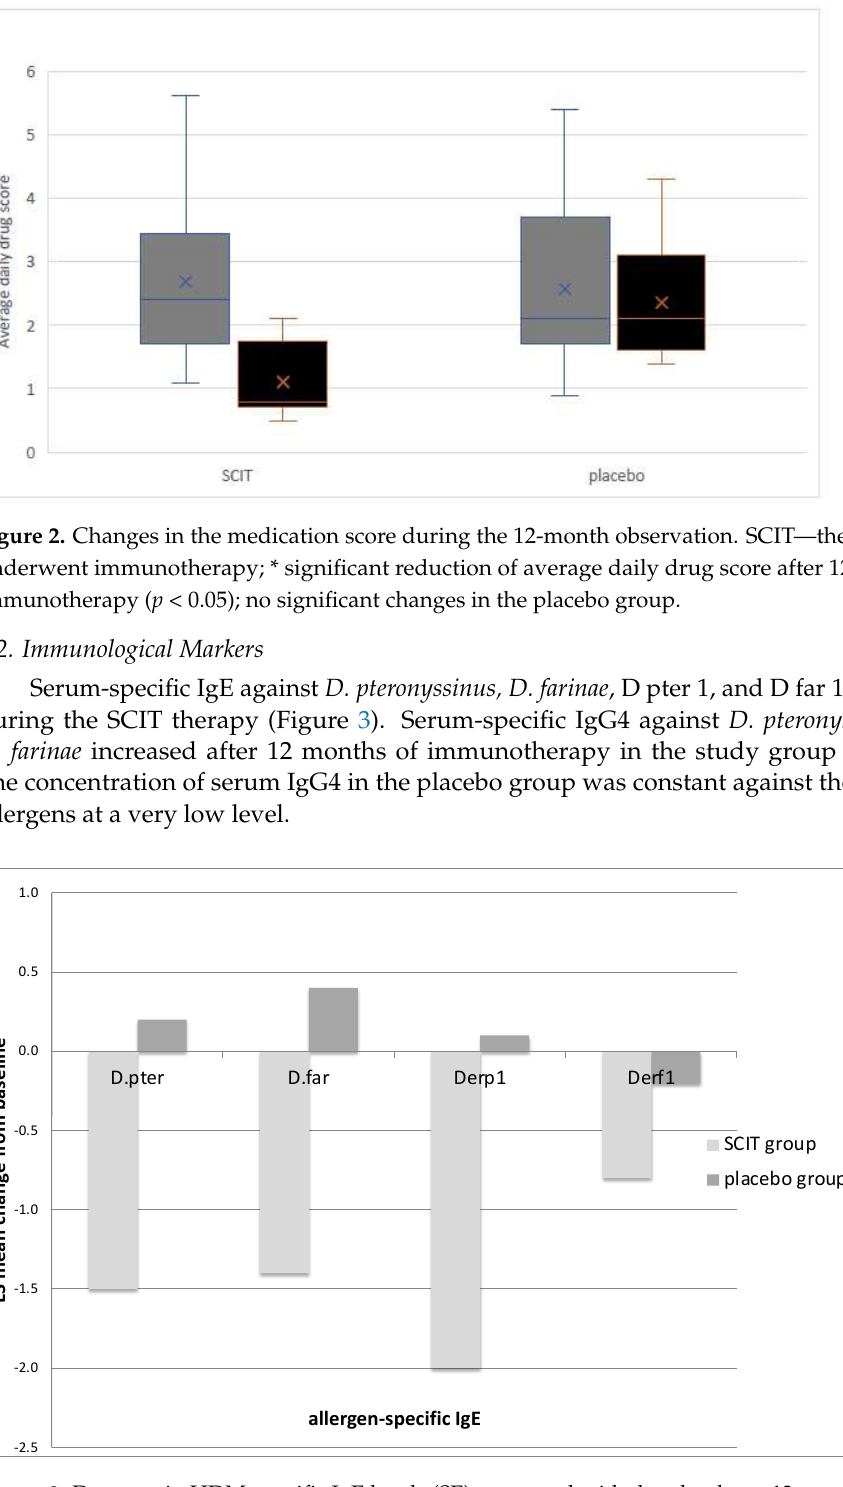
Figure 3. Decrease in HDM-specific IgE levels (SE) compared with the placebo at 12 months after the start of treatment. D. pter —mean change in IgE against D. pteronyssinus from baseline after 12 months of injection immunotherapy (SCIT) or a placebo; D. far —mean change in IgE against D. farinae from baseline after 12 months of SCIT or a placebo; Derp1—mean change in IgE against antigen D pter 1 from baseline after 12 months of SCIT or a placebo; Der f1—mean change in IgE against antigen Der f1 from baseline after 12 months of SCIT or a placebo. There were significant changes between the active and placebo groups in all analysed parameters.